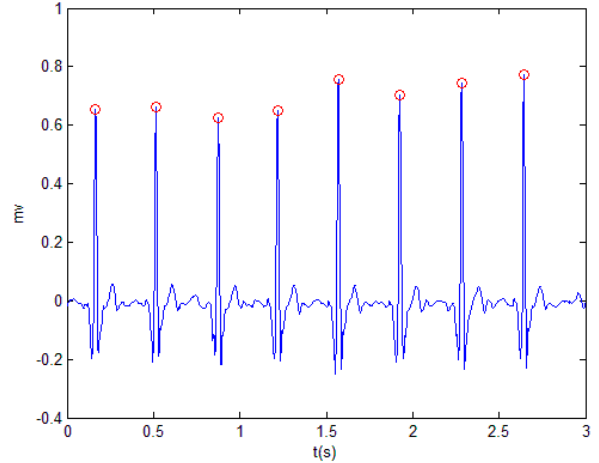
Figure 5. Find the position of the R wave based on discrete wavelet transform (DWT).